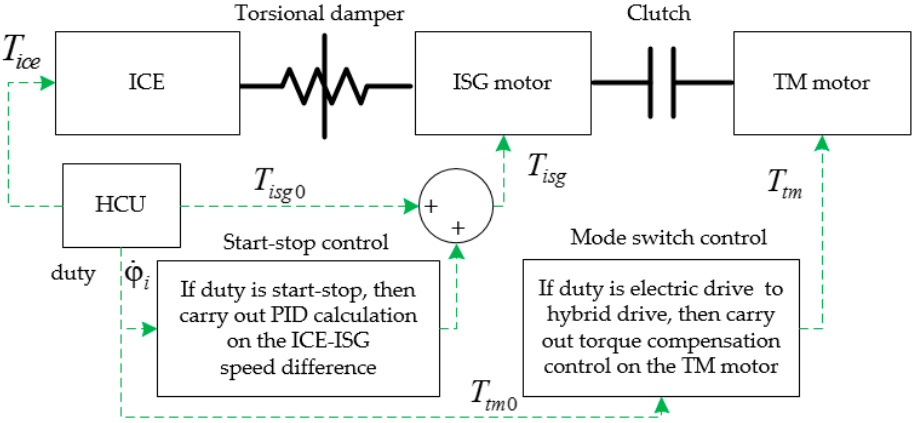
Figure 5. Active torsional vibration control method.